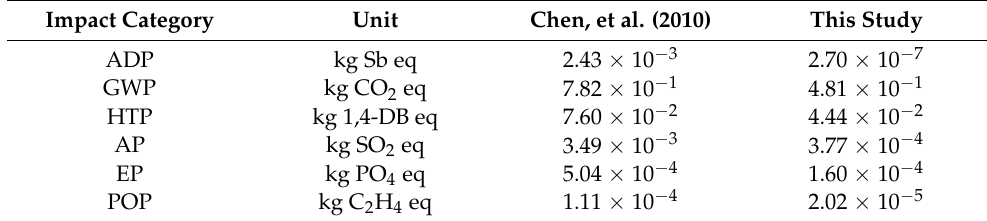
Table 5. Impact evaluation results compared with the study (Chen, et al. (2010) [43]) (CML-IA baseline method).